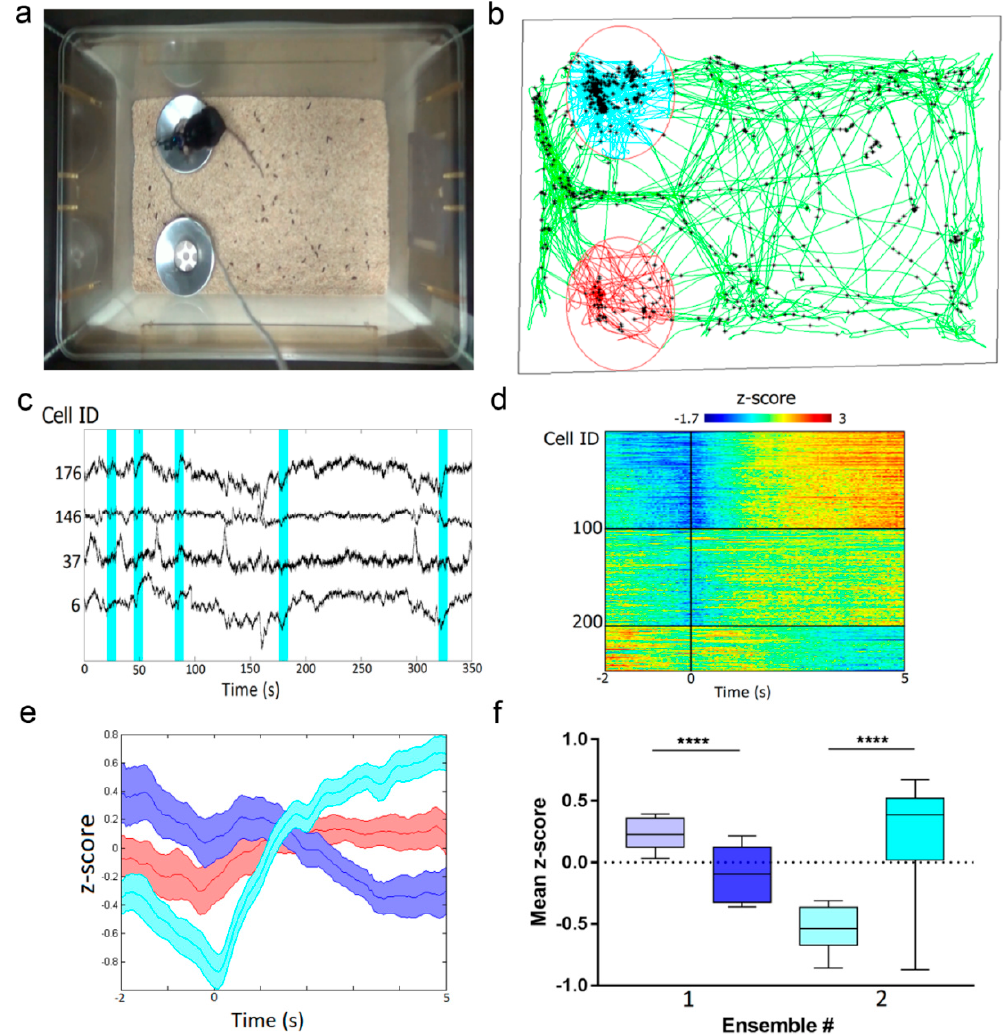
Figure 7. In vivo neuronal Ca2 + activity in mouse hippocampus during food intake visualized using FGCaMP7 and an nVista HD miniscope. ( a ) Photo of the mouse with an nVista HD miniscope mounted on its head during food intake. ( b ) Mouse trajectory for 1-h imaging session (green) with spikes from all detected neurons (black stars), red and cyan curves—trajectory in the area of cups. Context size: 40 cm by 30 cm. ( c ) Example normalized ∆ F / F0 Ca2 + signals for four individual neurons recorded during the session. Cyan areas show time windows 2 s before entering the cup area and 5 s after. ( d ) Mean responses of clustered groups of neurons upon cup area-entry transitions ( n = 253 neurons from two mice; number of entries, 17 and 24). Zero marks cup area-entry time points. Cells were ordered according to k-means clustering. ( e ) Average cup area-entry responses of activated (cyan), inhibited (blue) and indi ff erent (red) ensembles. Lines indicate the average across neurons ± SEM. ( f ) Average z-score at 2 s time window before entering the cup area and 5 s after for activated (#1) and inhibited (#2) ensembles. p values less than 0.0001 are given four asterisks.